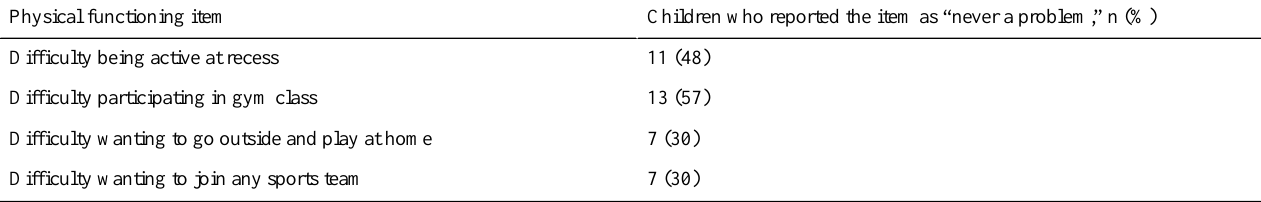
Table 7. Children’s reporting on physical functioning using the Pediatric Quality of Life Inventory